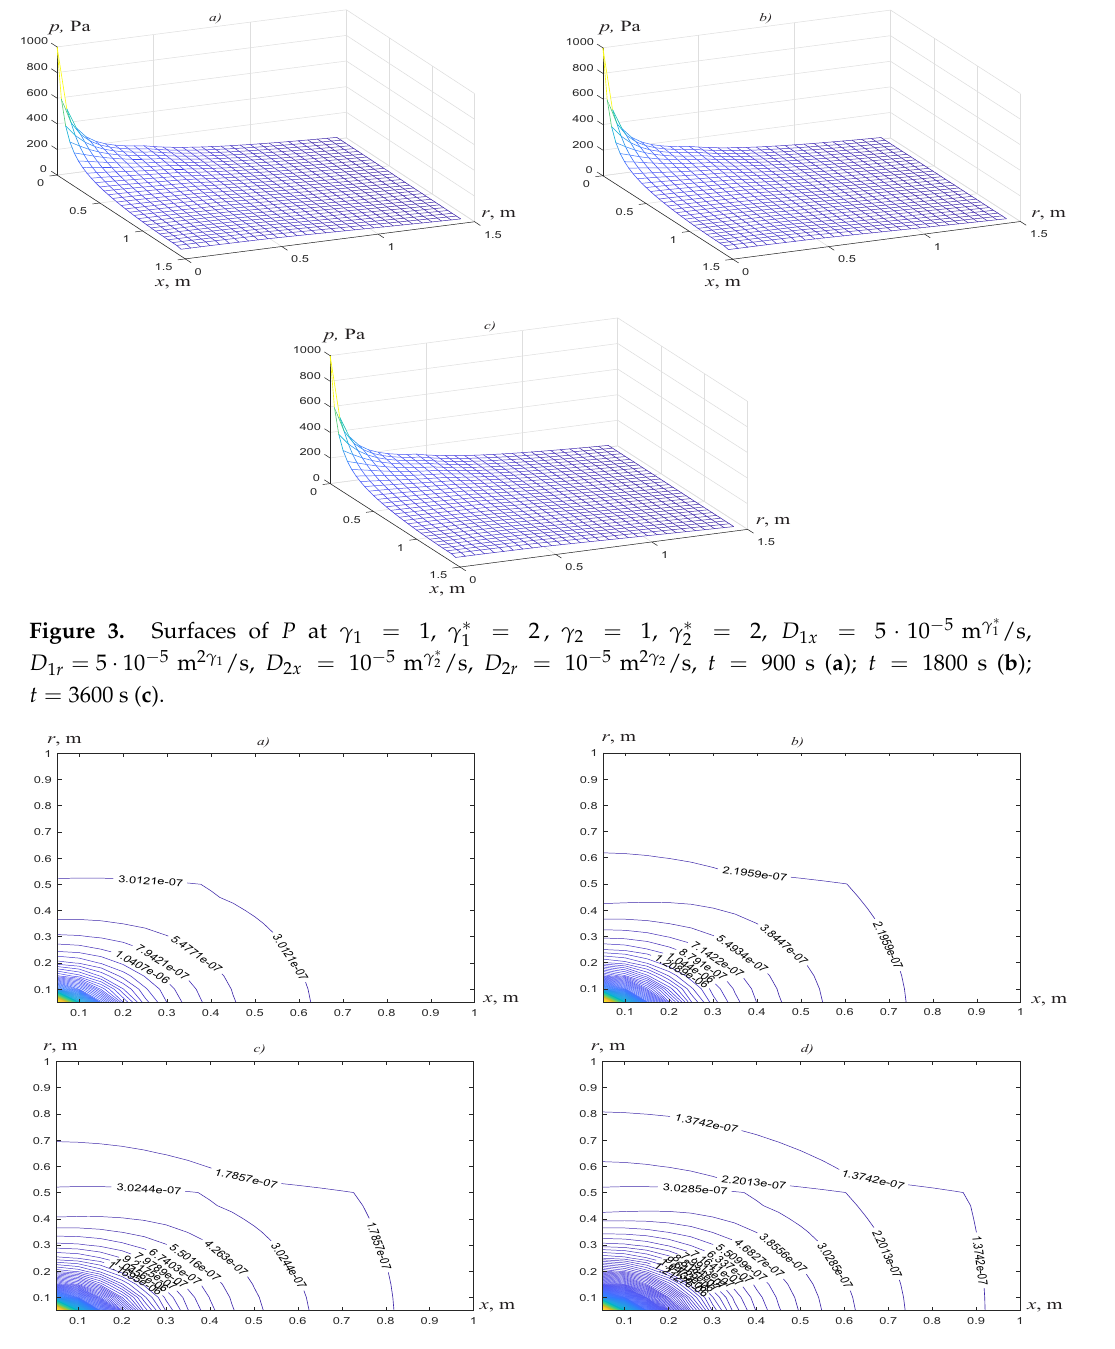
Figure 4. Filtration velocity fields, v , at t = 900 s ( a ); t = 1800 s ( b ); t = 3600 s ( c ); t = 7200 s ( d